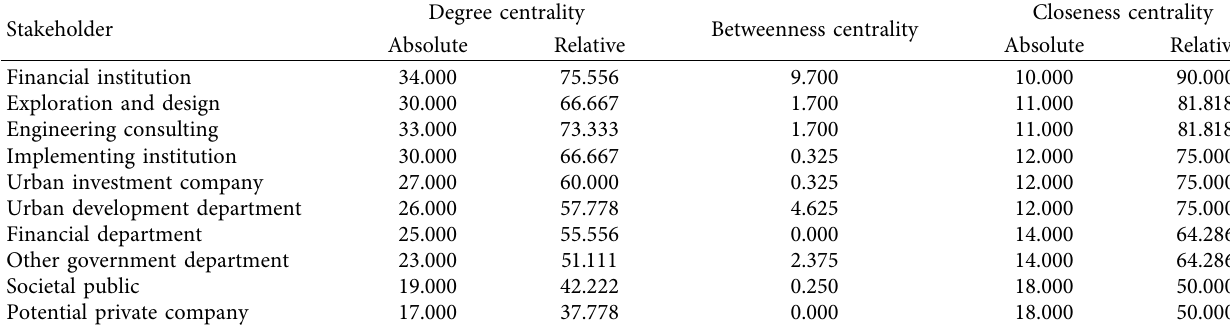
Table 4: Trust network centrality index.